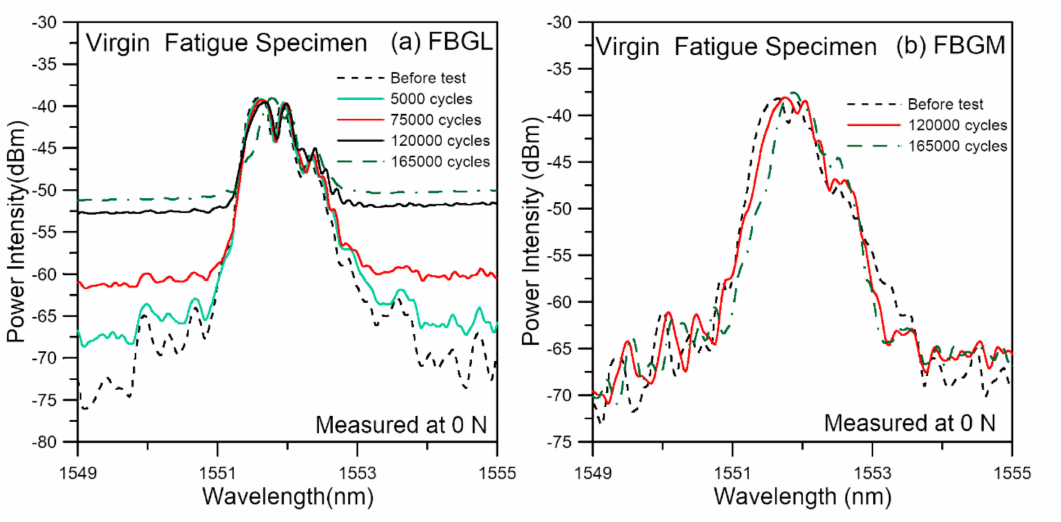
Figure 12. Evolution of typical unload FBG spectra from ( a ) FBGL and ( b ) FBGM, during fatigue cycling of a virgin